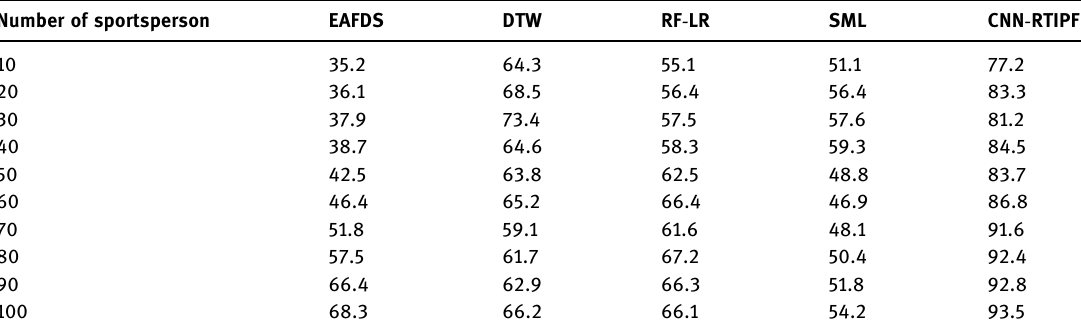
Table 1: Health management ratio ( % ) Number of